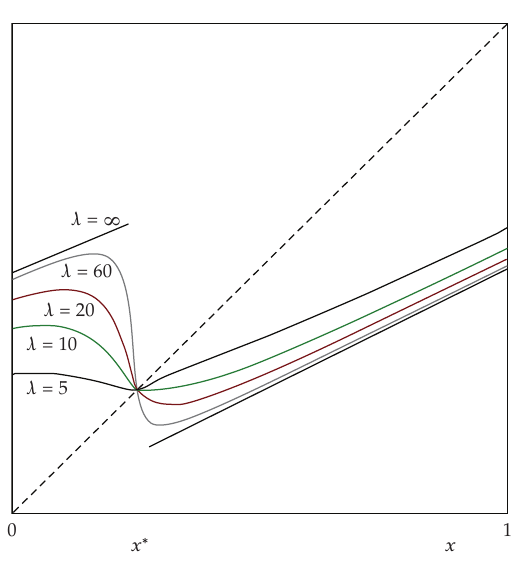
Figure 4: The map f for di ff erent values of parameter λ and in the limiting case λ (cid:7) ∞